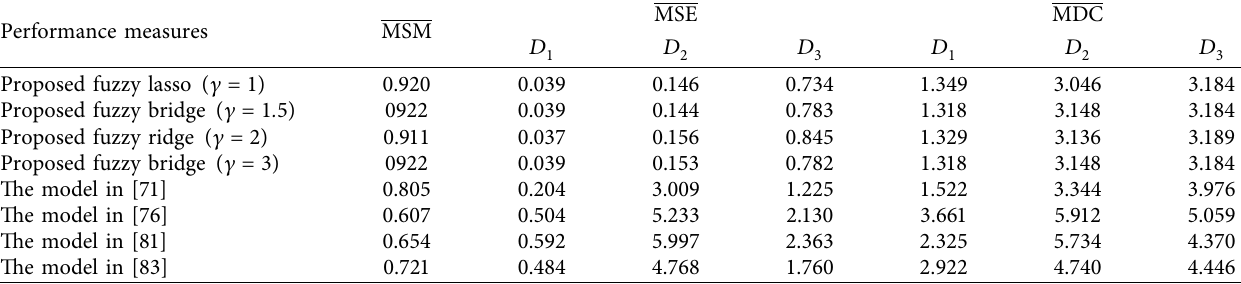
Table 1: Mean of 30 simulated performance measures of the proposed fuzzy bridge regression model with different values of c and some common fuzzy regression techniques in Example 1.